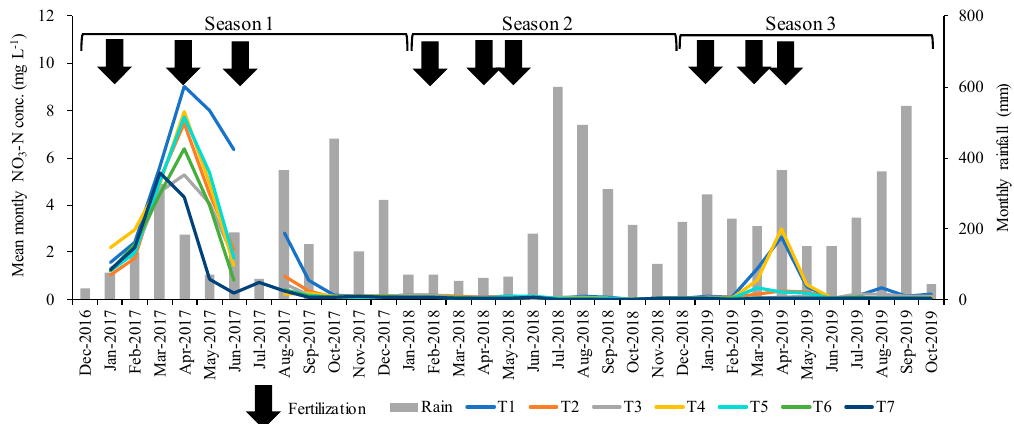
Figure 5. Mean monthly NO 3– N concentrations in the drainage water of different treatments (T1–T7) and monthly rainfall. Treatments refer to the different N fertilizer application rates shown in Table 2.